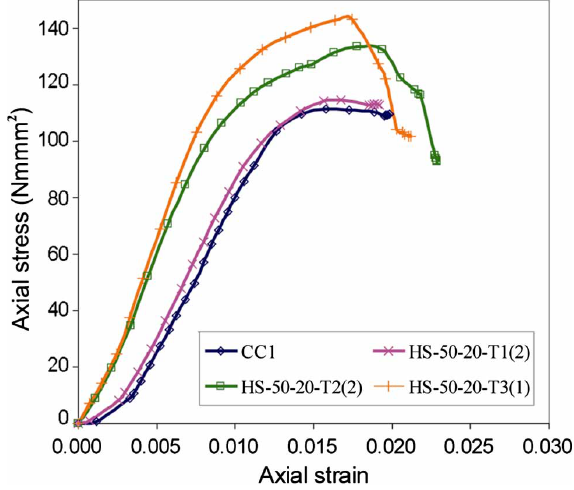
Fig. 12. Axial stress strain behaviour of columns HS-50-40 (cid:1)